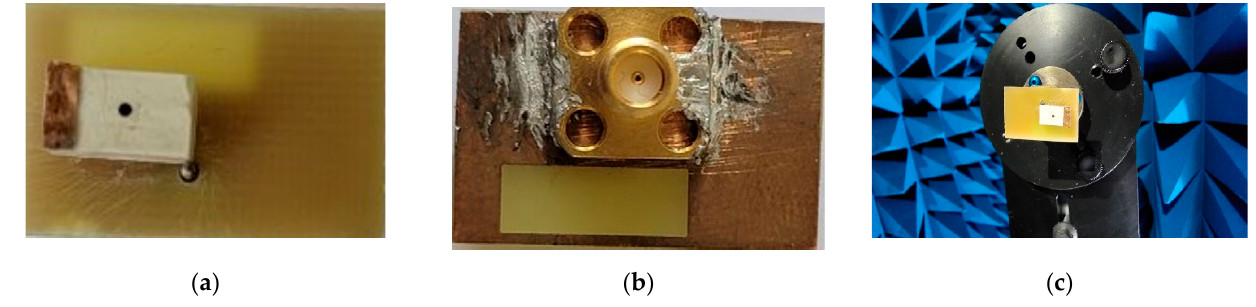
Figure 17. Fabricated prototype: ( a ) top view, ( b ) bottom view, ( c ) measurement setup in anechoic chamber.